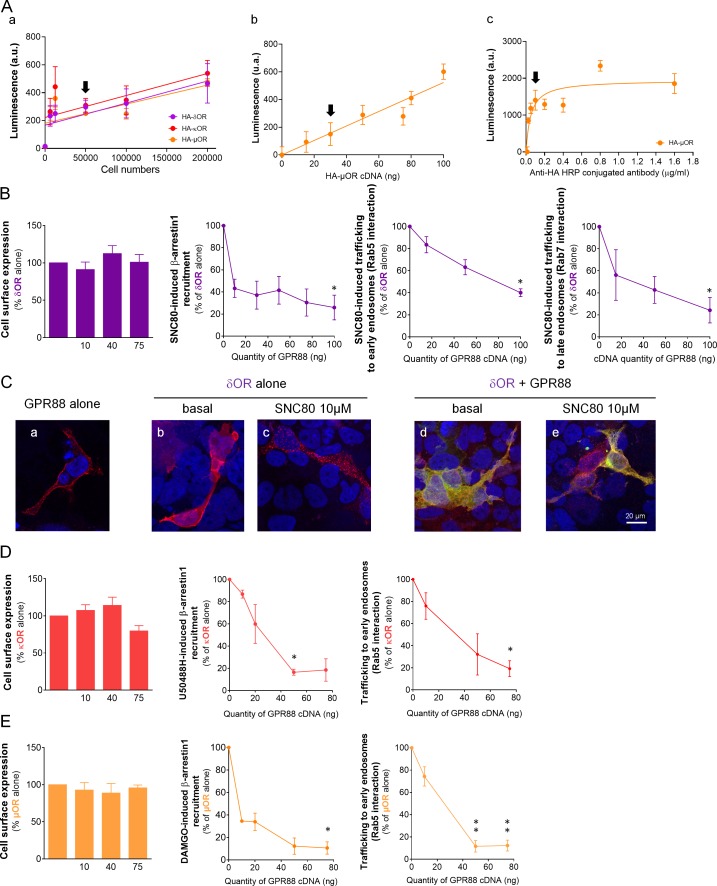
GPR88 inhibits opioid receptor signaling and trafficking in vitro.(A) We assessed whether the polyclonal anti-HA HRP-conjugated antibody allowed to satisfyingly detect modifications in the cell surface expression of HA-tagged opioid receptors. (a) The antibody displayed a linear response to increasing amounts of HA-tagged GPCR-expressing cells in the 50,000 to 200,000 range (n = 2–4 per receptor, in triplicates). Further tests used 50,000 cells per assay (black arrow). (b) When the cell number was set at 50,000, the anti-HA HRP-conjugated antibody allowed reliable detection of increasing amounts of transfected HA-tagged µOR (n = 4, in triplicates). Further used 30 ng of HA-tagged GPCR cDNA for transfection (black arrow). (c) At the 1:10,000 concentration (black arrow), the antibody allows optimal detection of HA-µOR (n = 1, in triplicates). This concentration was used for further testing. (B) Increasing amounts of GPR88 cDNA did not affect HA-δOR cell surface expression (left panel) but blunted SNC80 (10 µM)-induced Ypet-β-arrestin1 (β-arr1) recruitment and δOR-Rluc8 trafficking (early endosome sensor: Rab5-Venus; late endosome sensor: Rab7-Venus) in HEK293FT cells. (C) Confocal microscopy images show (a) HA-GPR88 expression at cell surface, (b) HA-δOR localized at cell surface, (c) internalized under SNC80-stimulation, (d) HA-δOR (red) and GPR88-Venus (green) co-localized at cell surface, (e) GPR88 inhibition of δOR internalization with cell nuclei stained using DAPI coloration. (D) Co-expressing GPR88 with HA-κOR did not affect κOR cell surface expression but blunted U50488H (10 µM)-induced Ypet-β-arr1 recruitment and κOR trafficking (early endosome sensor: Rab5-Venus) in HEK293FT cells. (E) Co-expressing GPR88 with HA-µOR did not affect µOR cell surface expression but blunted DAMGO (10 µM)-induced Ypet−β-arr1 recruitment and µOR-Rluc8 trafficking (early endosome sensor: Rab5-Venus; late endosome sensor: Rab7-Venus) in HEK293FT cells. Data (B–E) are presented as mean ± SEM of n = 3–5 independent experiments (performed in triplicates). BRET1 values are presented as induced BRET (normalized as the percentage of maximal BRET values in absence of GPR88) by Venus/Rluc8 BRET ratio. Asterisks: Kruskal-Wallis ANOVA, multiple comparison of mean ranks *p<0.05, **p<0.01.